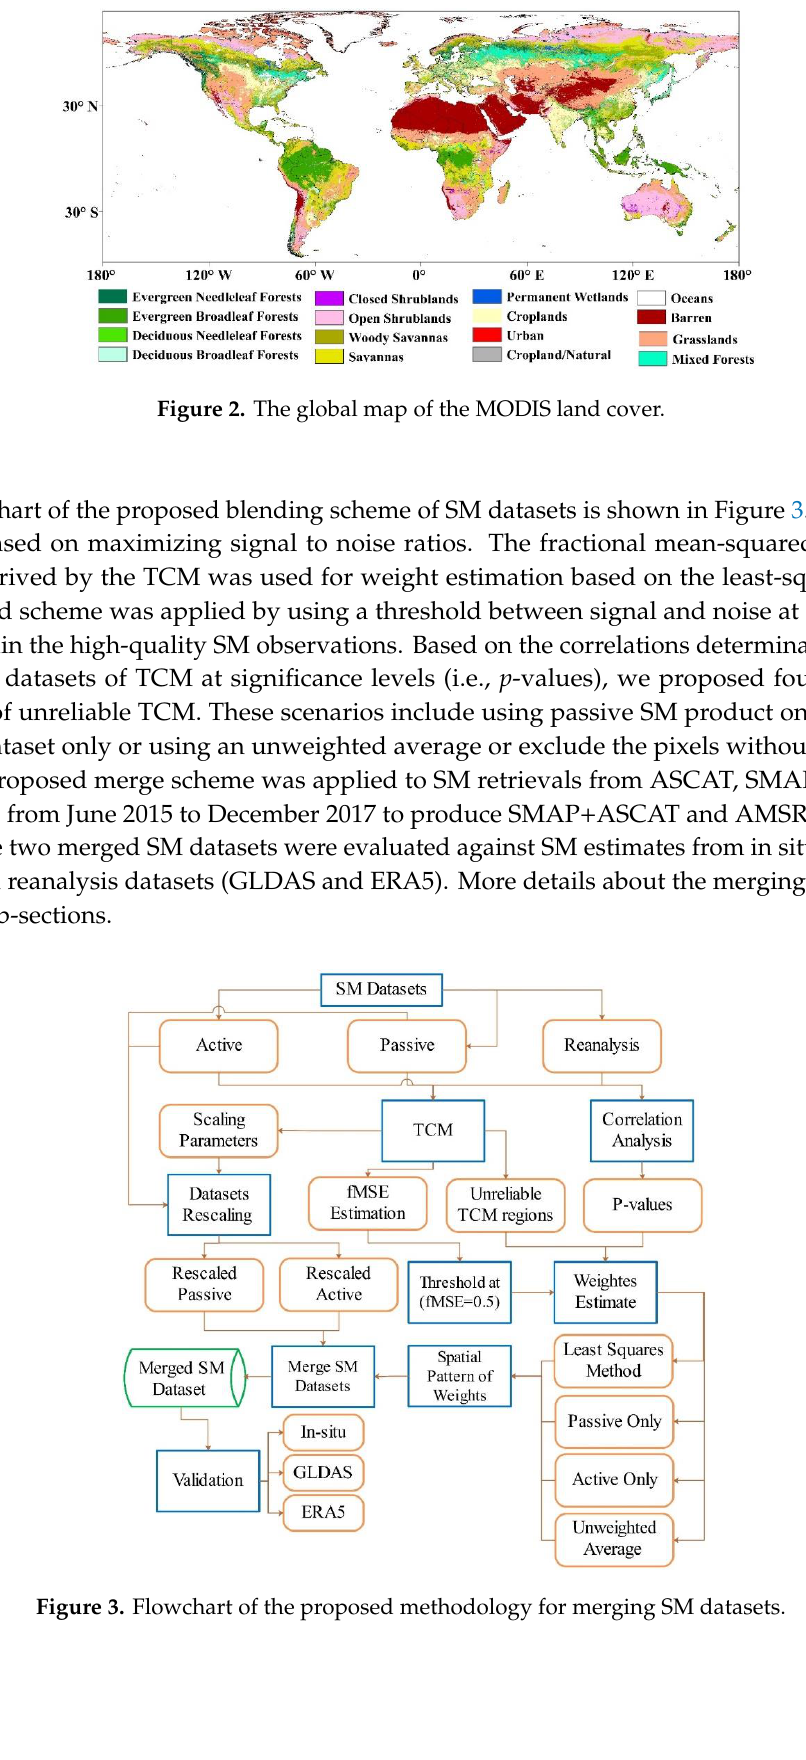
Figure 3. Flowchart of the proposed methodology for merging SM datasets.